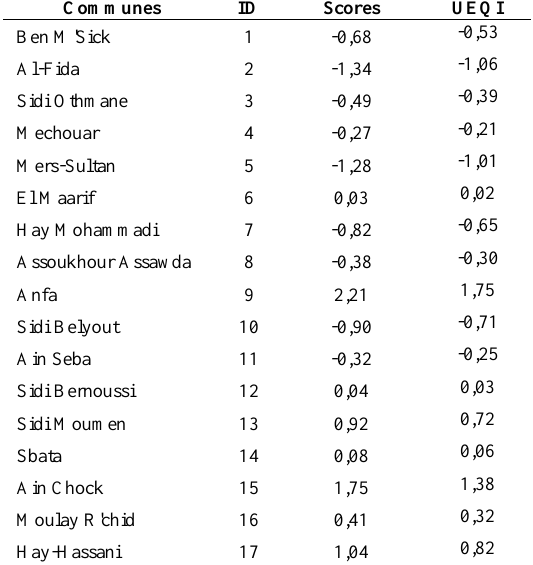
Table 5. Component scores for communes.